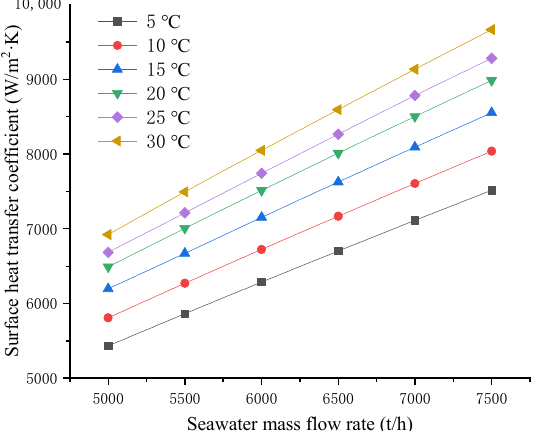
Figure 4. Surface heat transfer coefficient of the pipe side under different seawater temperatures and seawater flow rates.